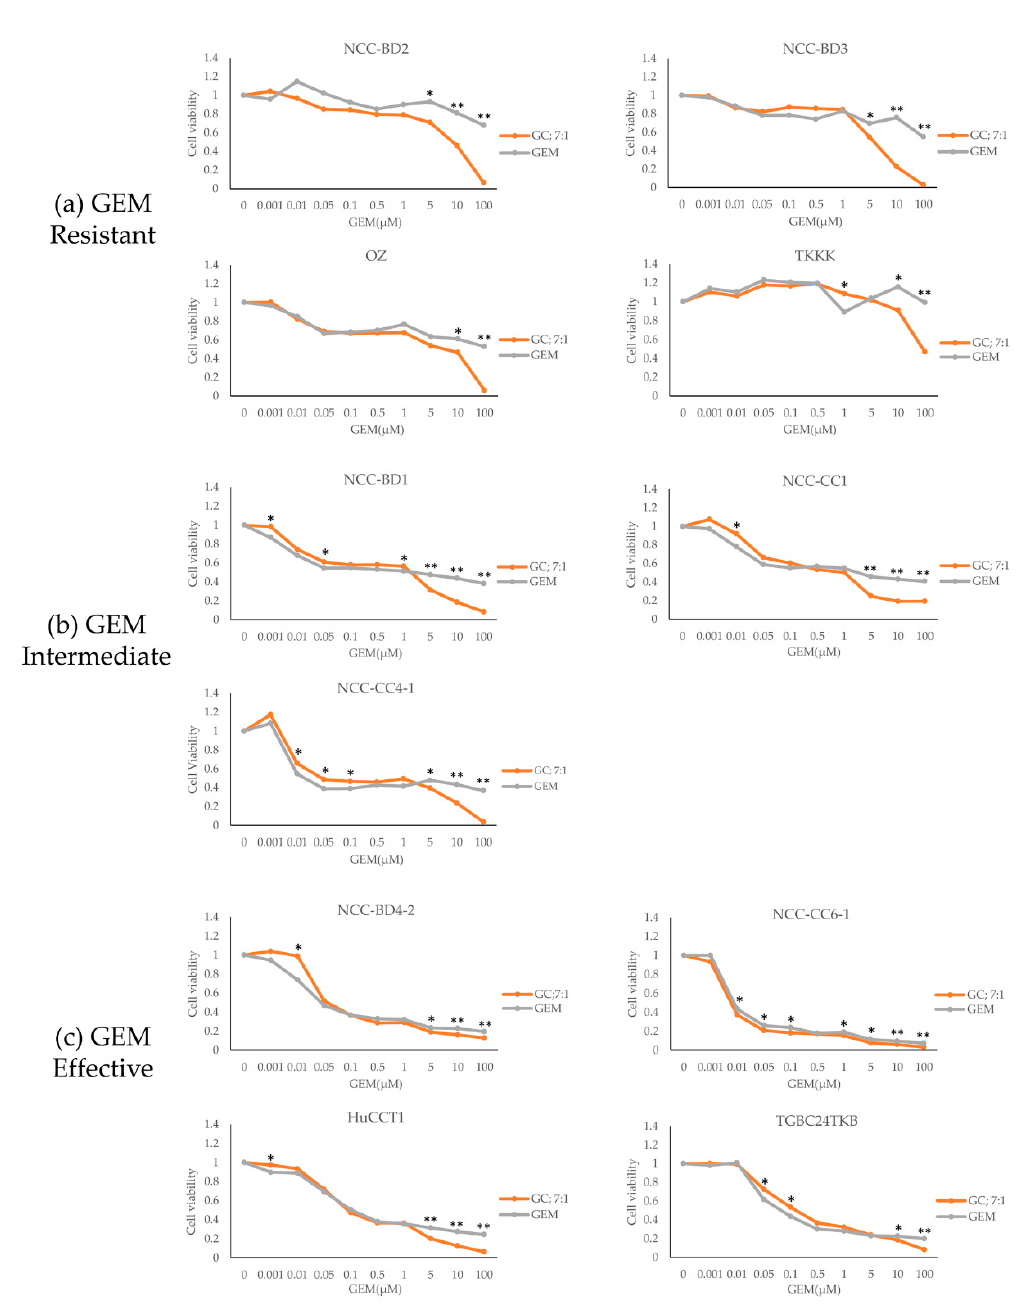
Figure 3. The dose–response curves for combined administration of GEM–CDDP at a molar ratio of 7:1 and administration of GEM alone. Cell lines are stratified into three groups based on their sensitivity to GEM: ( a ) GEM resistant group, ( b ) GEM intermediate group, and ( c ) GEM e ff ective group. There was a di ff erence between the IC50 levels for GC and GEM alone for the four GEM-resistant cell lines. The dose–response curves for GC and GEM alone were compared. * P < 0.05 and ** P < 0.0001 by Student’s t -test. Statistical significance was set at P < 0.05.